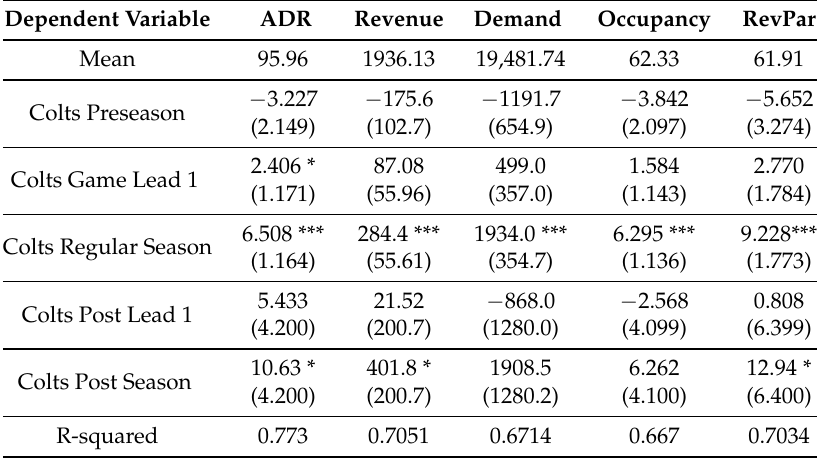
Table 7. The impact of Indianapolis Colts games on the hotel